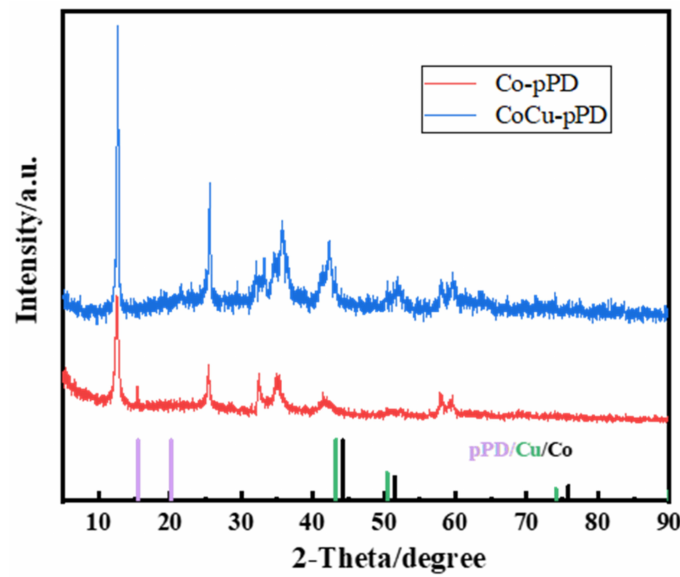
Figure 2. XRD patterns of Co-pPD and